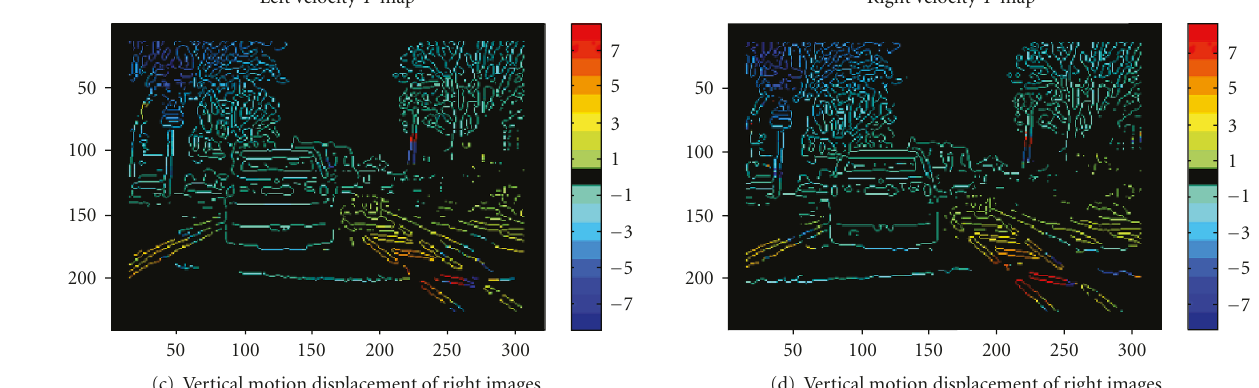
(c) Vertical motion displacement of right images (d) Vertical motion displacement of right images Figure 3: Optic flows for left and right images using edge-indexed crosscorrelation matching.